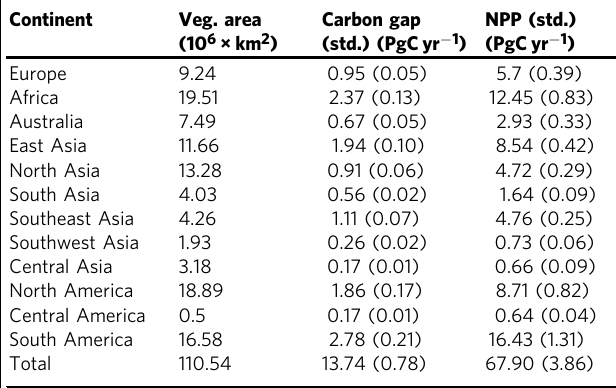
Table 1 Statistical summary of the total carbon gap and NPP of the continents (regions). Continent